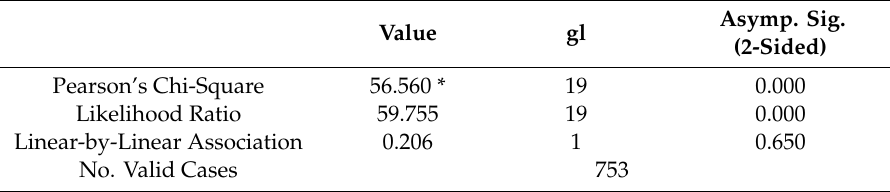
Table 4. Pearson’s Chi-square ( χ 2 ) Test for Kinect